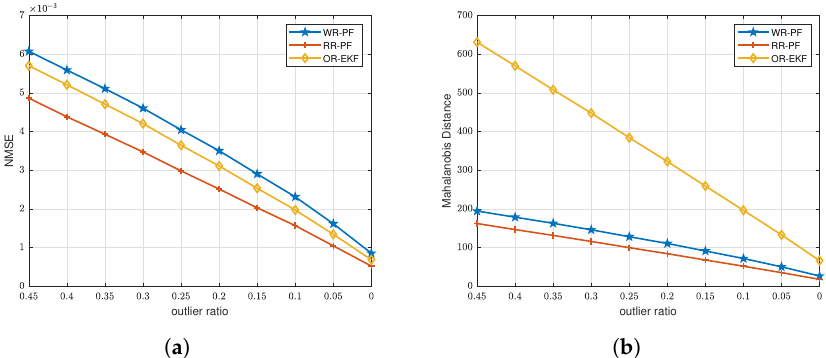
Figure 8. Estimated errors versus only radial velocity outliers in multidimensional measurements. ( a ) NMSE comparisons. ( b ) Mahalanobis distance comparisons.